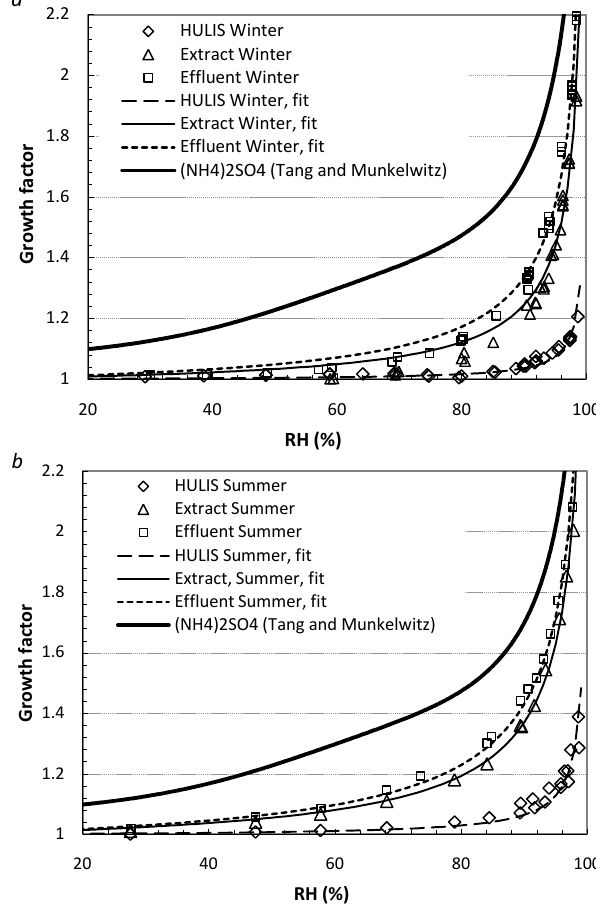
Fig. 2. Measured hygroscopic growth of K-puszta winter (a) and summer (b) samples and fitted functions for particles with a dry diameter of 100nm without pre-humidification of the aerosol. The growth factors are corrected according to efflorescence mea- surements, which indicate a slight restructuring of the particles. The solid line represents ammonium sulphate data from Tang and Munkelwitz (1999). The lines denoted fit are parameterizations ac- cording to Eq.